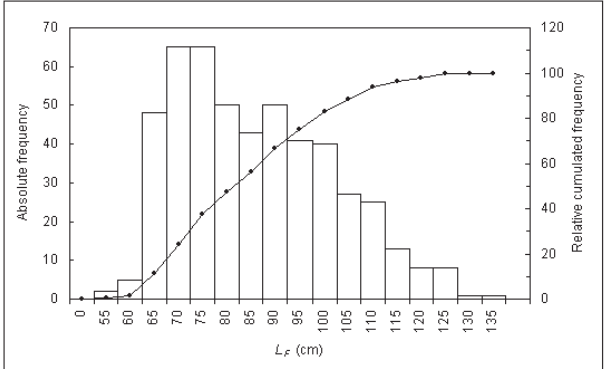
Fig. 2 . Size distribution of absolute frequency (columns) and relative cumulated frequency (line) for total sampled of black grouper Mycteroperca bonaci .